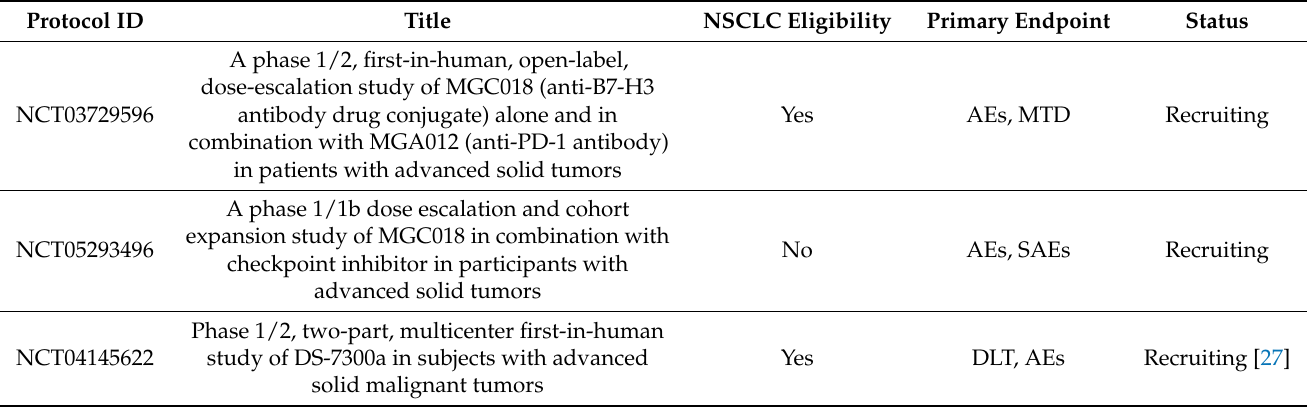
Table 2. Main ongoing clinical studies investigating B7-H3 inhibitors in solid tumors including NSCLC